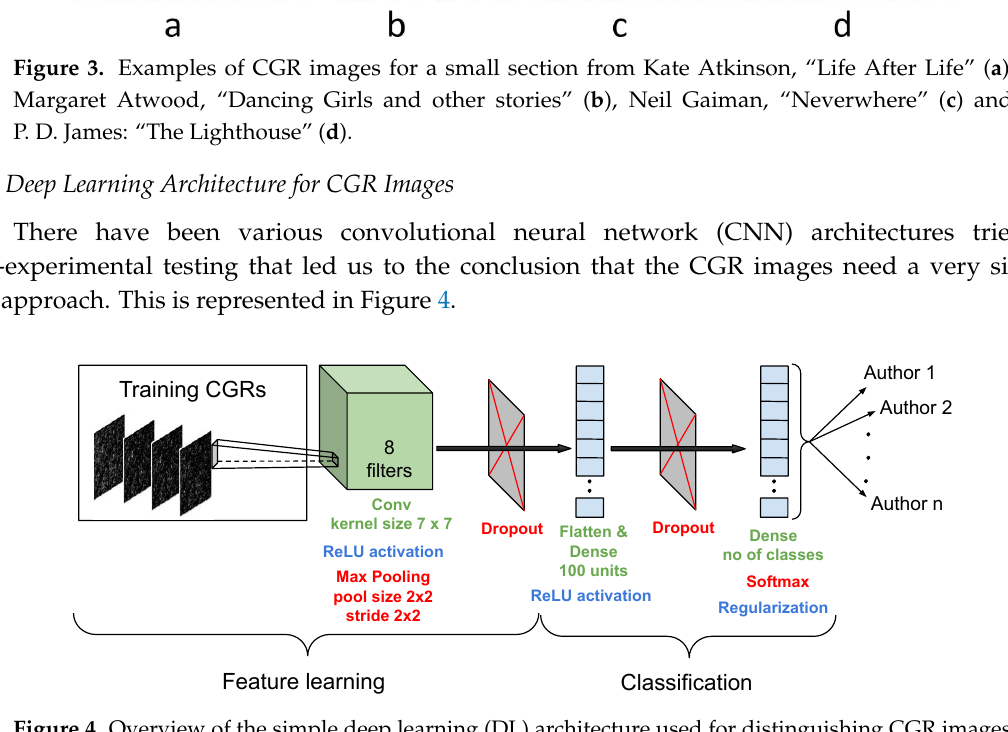
Figure 4. Overview of the simple deep learning (DL) architecture used for distinguishing CGR